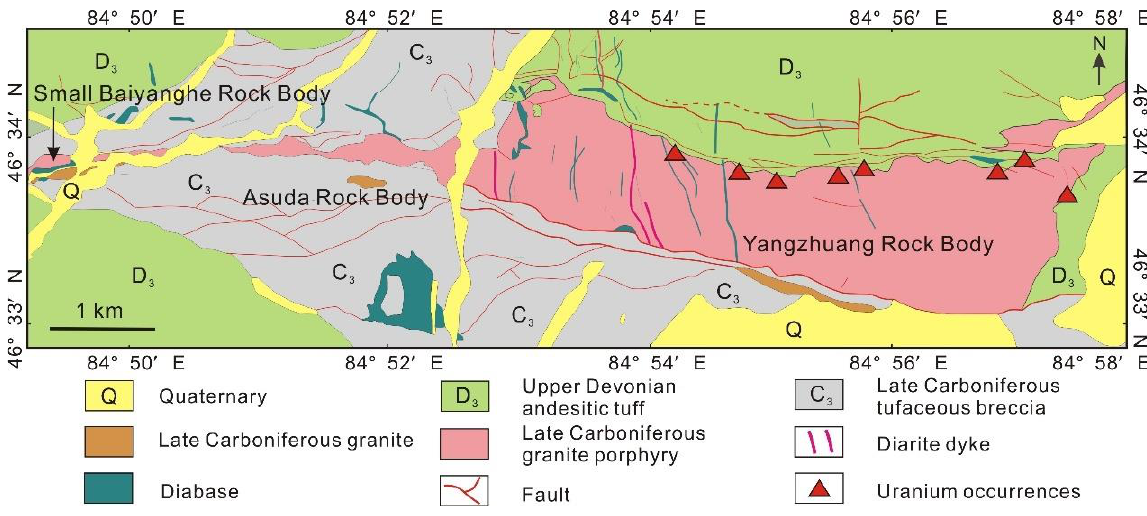
Figure 1. Geological map of the Baiyanghe uranium deposit (modified from [2,35]).